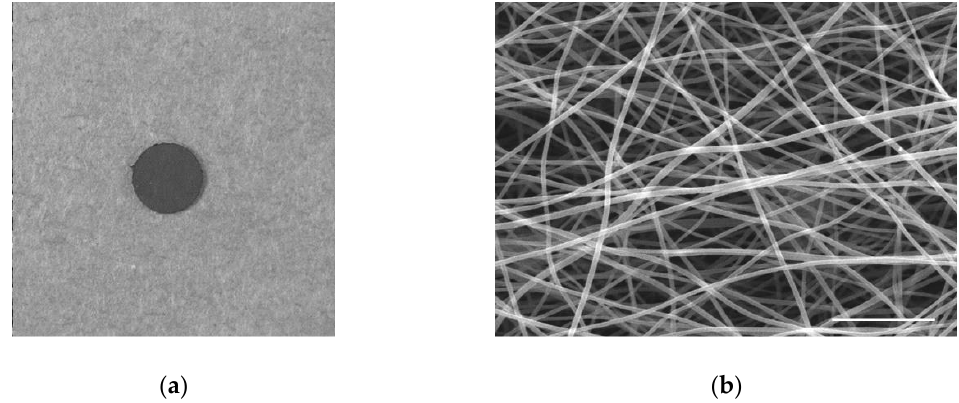
Figure 2. 250 nm type thin carbon nanofiber web (TCFW). ( a ) Macroscopic view of implant for animal testing (diameter: 5 mm); ( b ) Scanning electron microscopy image. Nanofibers are presented as web structures. Scale bar, 5 μm.